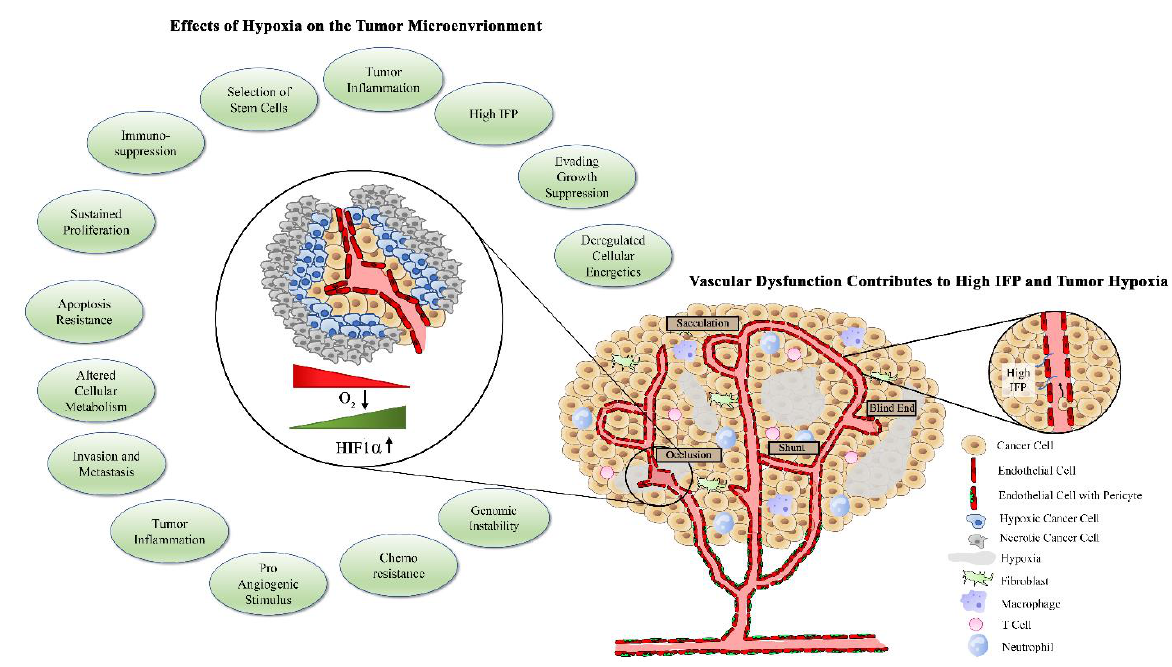
Figure 2. Tumor hypoxia activates several tumorigenic processes. Tumor vasculature has altered morphology, with reduced pericyte coverage. The immature tumor vessels are characterized by blind end shunts, torturous pathway, sacculations, decreased luminal size, and increased fenestrations. Excessively fenestrated vessels allow for fluid extravasation and increased interstitial fluid pressure (IFP) and facilitate intravasation and migration of metastatic tumor cells. Elevated IFP and disrupted tissue perfusion contribute to areas of acute and chronic hypoxia, which can activate numerous pro- tumorigenic